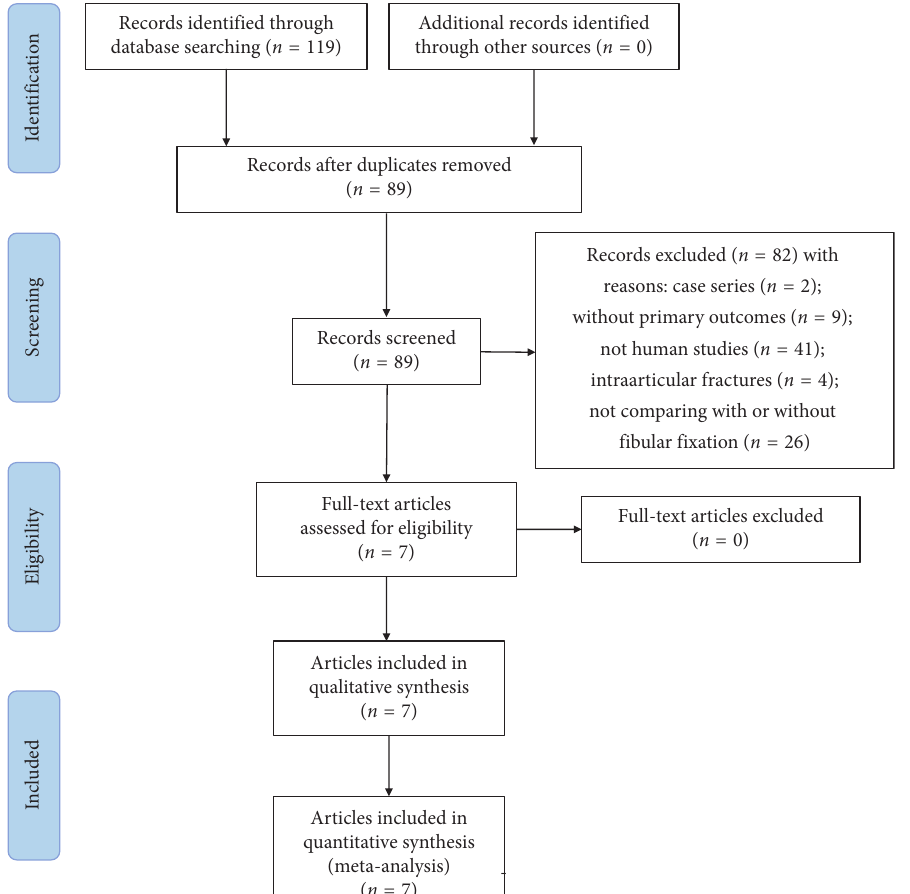
Figure 1: Flow diagram of literature research and the selection